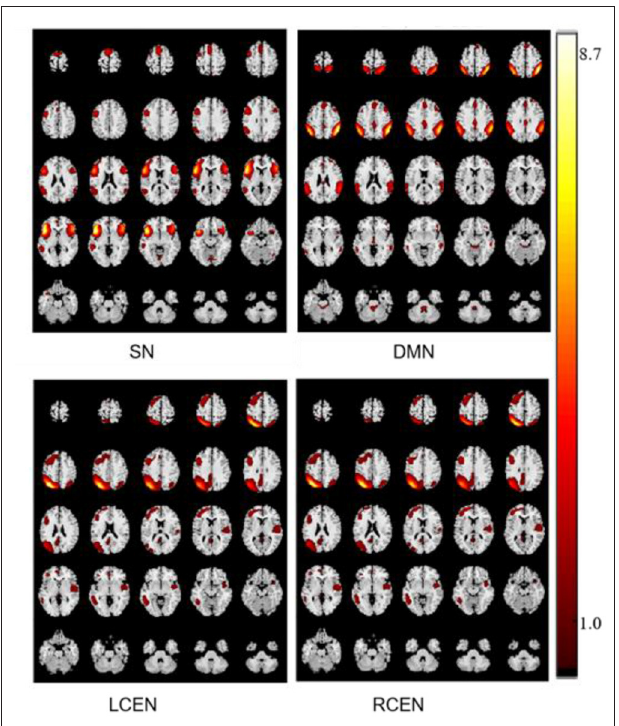
FIGURE 2 | The spatial distribution of components in SN, DMN, left CEN, and right CEN.